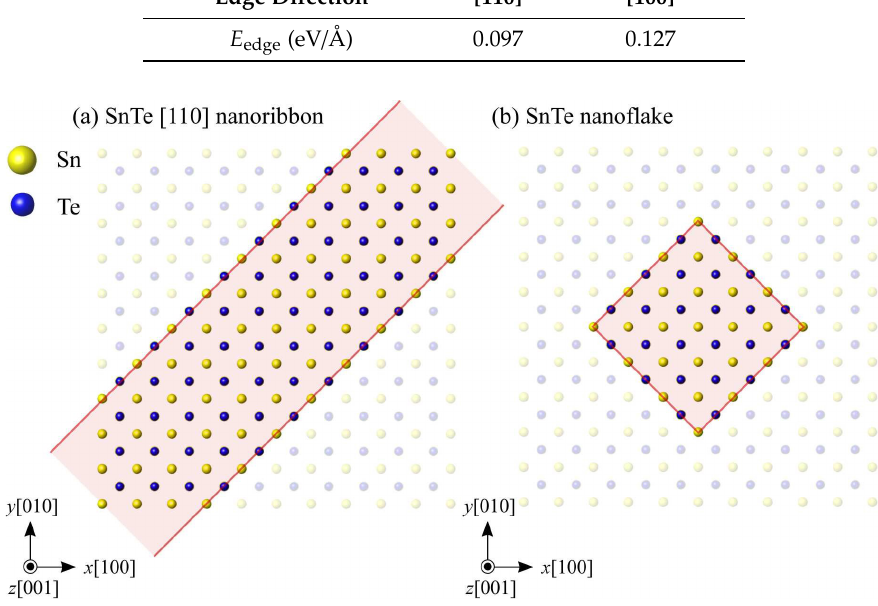
Figure 1. Schematic illustration of ( a ) SnTe nanoribbon and ( b ) SnTe nanoflake.